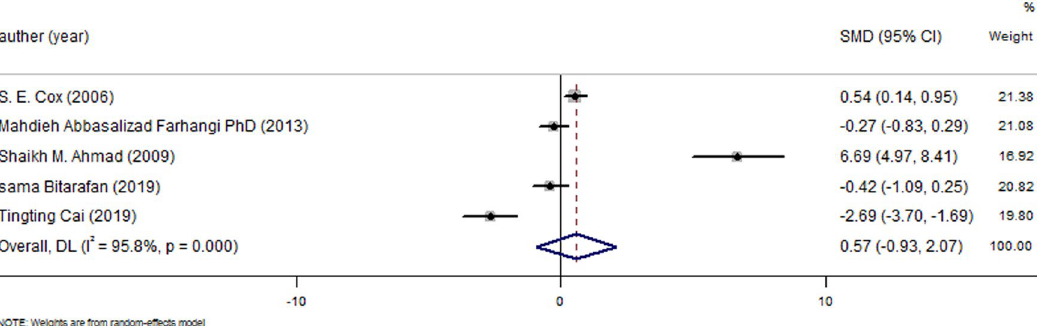
protein, SMD standardized mean difference, CI confidence interval.